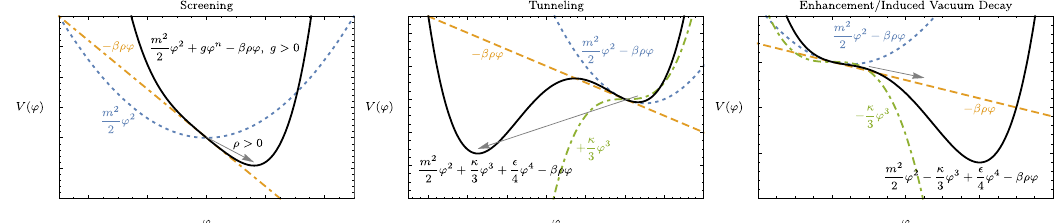
Figure 1 . Qualitative behavior of the scalar potential V for a (cid:12)fth force mediated by ’ that gives rise to screening (left), tunneling (middle) and enhancement (right). In each panel we show the original potential in the presence of only the quadratic term and the coupling to matter (dotted blue), the e(cid:11)ect of the coupling to matter (dashed yellow), and the e(cid:11)ect of a cubic self-interaction term (dot-dashed green), with the full potential in black. In the left panel, the dotted blue line shows the quadratic term only. Left: the coupling to matter shifts the minimum, resulting in a steeper potential, re(cid:13)ecting m e(cid:11) ¡ m inside a dense object. If m (cid:1) 1 is smaller than the size of the e(cid:11) source, its ’ charge is screened. Middle: a cubic term (cid:20)’ 3 in the potential term generates a deep minimum, making our vacuum at ’ (cid:16) 0 susceptible to tunneling. Right: if (cid:12)(cid:20) (cid:160) 0, (cid:12)nite density e(cid:11)ects can result in enhancement of the scalar charge if ’ attains a value close to the true minimum and returns to ’ (cid:19) 0 away from the source. If the source is su(cid:14)ciently dense (or the cubic large enough), ’ does not return to ’ (cid:16) 0 outside of the source and instead evolves to the true minimum, resulting in classical vacuum